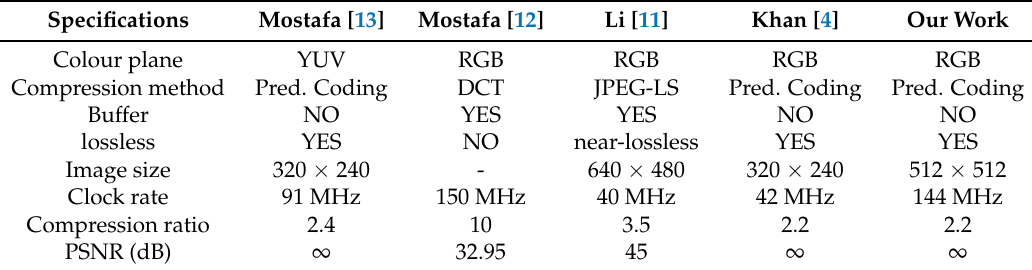
Table 7. Comparison between proposed method and other existing